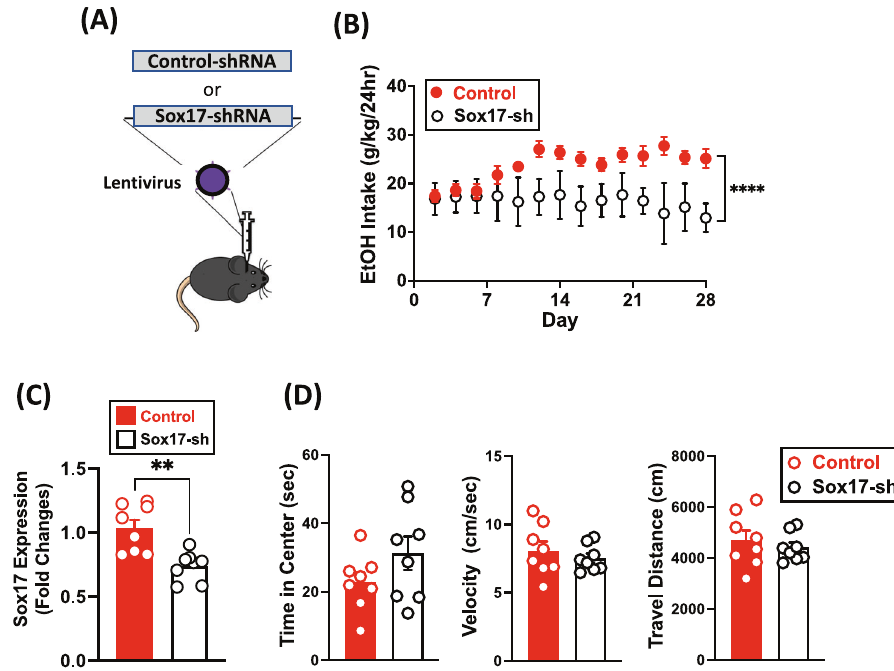
Fig. 3 Downregulation of Sox17 in the amygdala reduces alcohol consumption. A Schematic illustrating the surgical strategy with a lentivirus encoding Sox17-shRNA. B Alcohol intake of mice bilaterally injected with either control or Sox17-shRNA lentivirus into the amygdala. The injection was conducted 2 weeks before subjecting the animals to EOD paradigm. C Changes of Sox17 expression were examined by qPCR in Sox17 shRNA- or control lentivector-injected mice. D Downregulation of Sox17 expression does not lead to signi fi cant changes in anxiety (time spent in the center of an open fi eld) or locomotion (speed and travel distance). Data are mean ± SEM. ** p < 0.01 and **** p < 0.0001 difference between